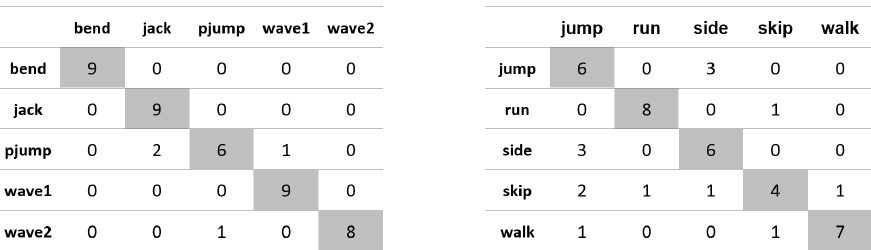
Figure A1. Confusion matrices for the experiment using the ‘lower-occlusion’ database, rectangular- ity and Euclidean distance.